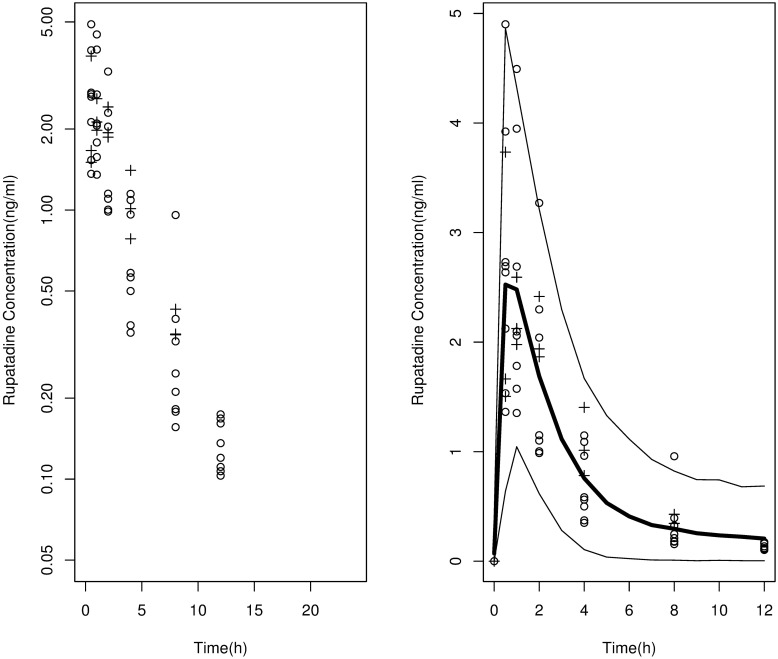
Time profile of the observed plasma concentrations of rupatadine in 6–11 year olds after the administration of 2.5-mg (crosses) or 5-mg (open circles) doses.Left panel, observed concentrations of rupatadine in log scale. Right panel, visual predictive check of the final selected model built with data for rupatadine in 6–11 year olds. Solid thin lines cover the area including 90% percentile interval of the simulated plasma concentrations over time, and thick line represents the mean of the simulated profiles. Concentrations have been normalised to a 5-mg dose.